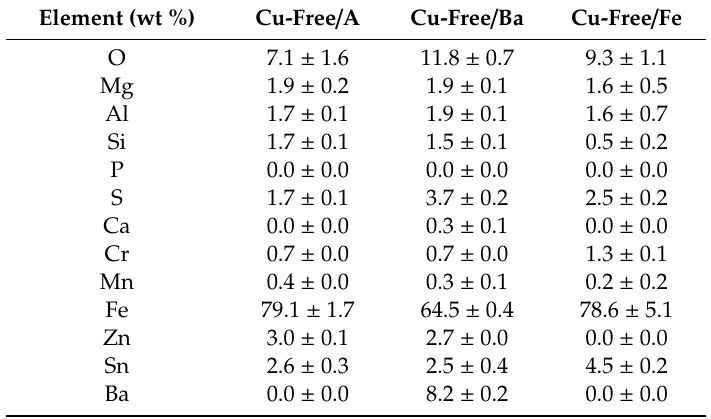
Figure 8. SEM micrographs of the airborne particles in the10–2.5 µm range of the three friction materials. Table 5. Elemental composition, in weight percentage, of the airborne particles in the 10–2.5 µm range of the three friction materials.